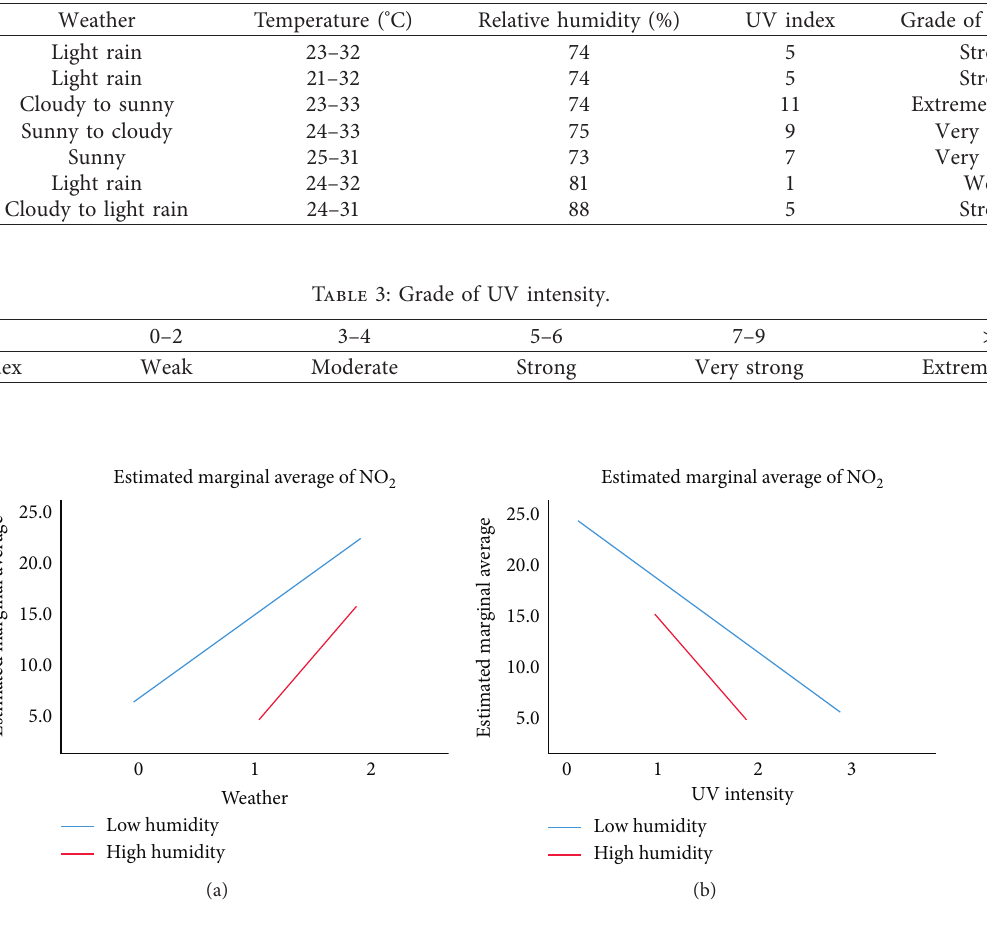
Table 2: Environmental conditions within seven days after construction.